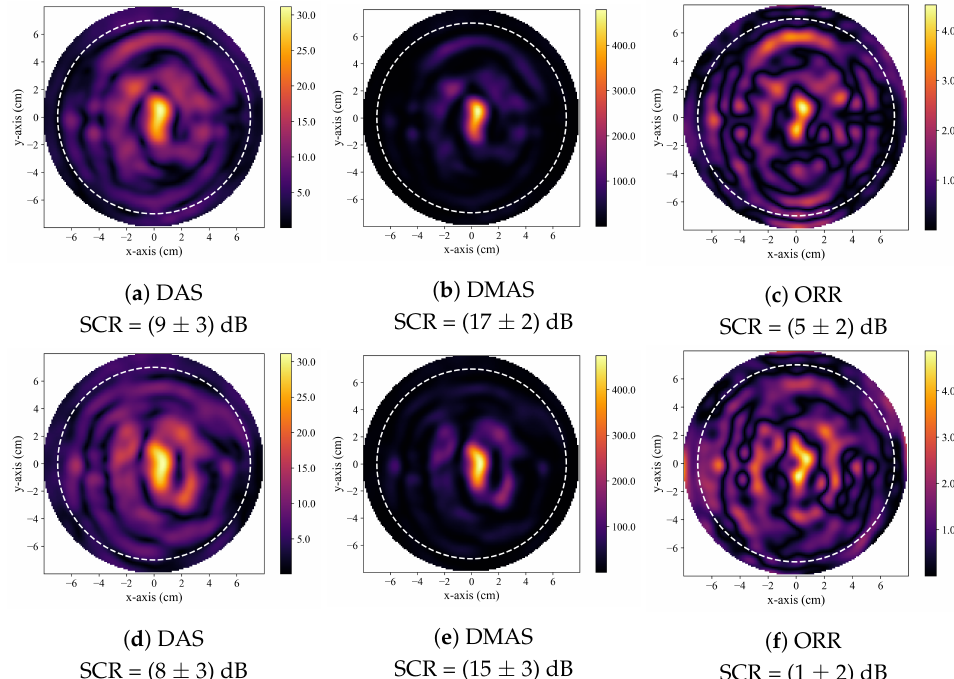
Figure 5. Typical reconstructed images produced by DAS in ( a , d ), by DMAS in ( b , e ), and by the ORR in ( c , f ). All reconstructions are of healthy, tumour-free phantoms. In all reconstructions, the dashed white circle indicates the approximate outer boundary of the breast phantom, and the solid green circle indicates the known tumour